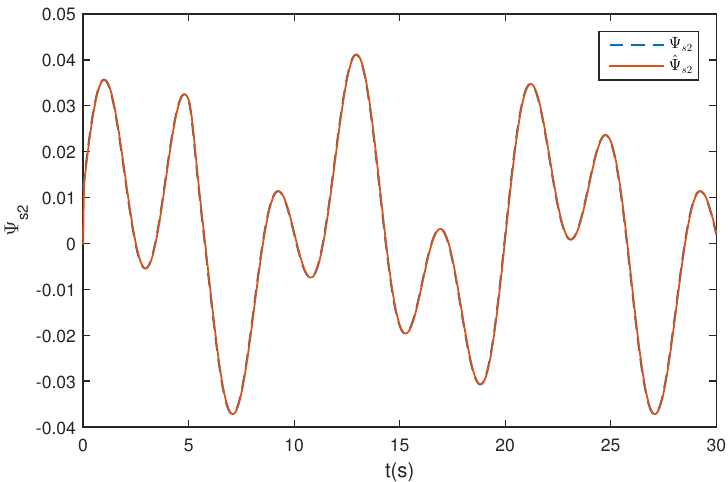
Figure 8. Estimation of Ψ s 2 in attitude tracking.